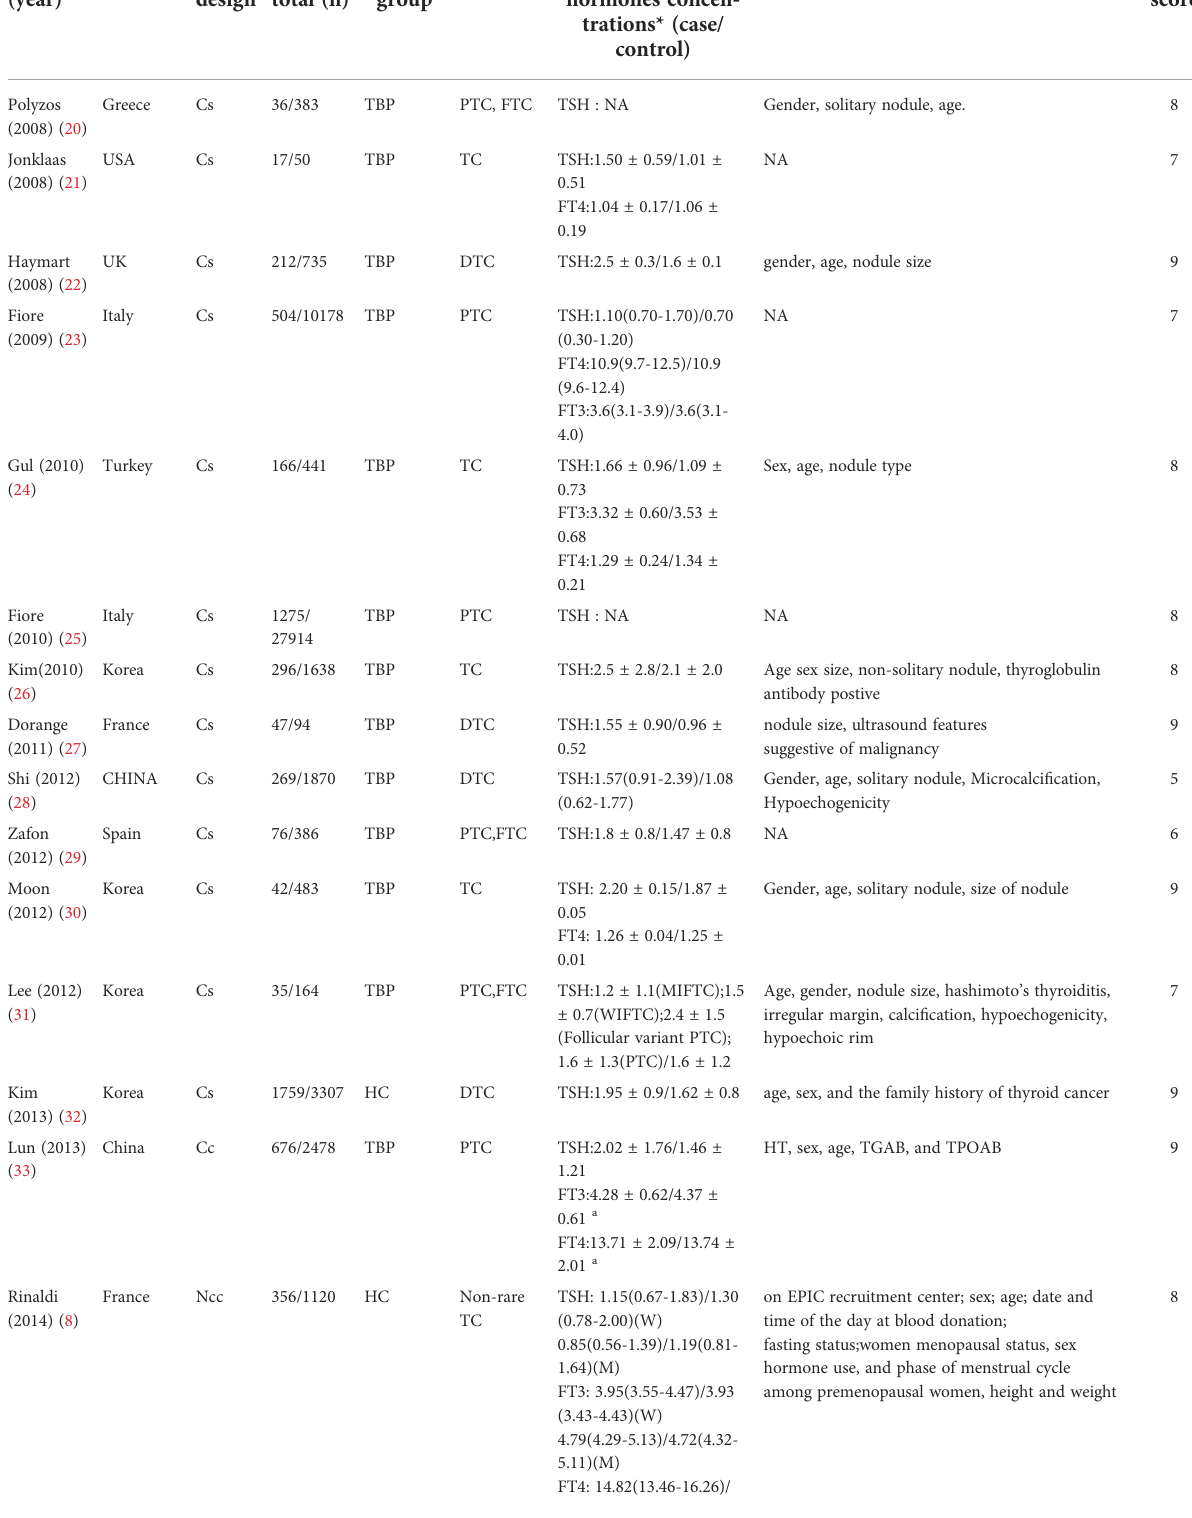
TABLE 1 Overview of included